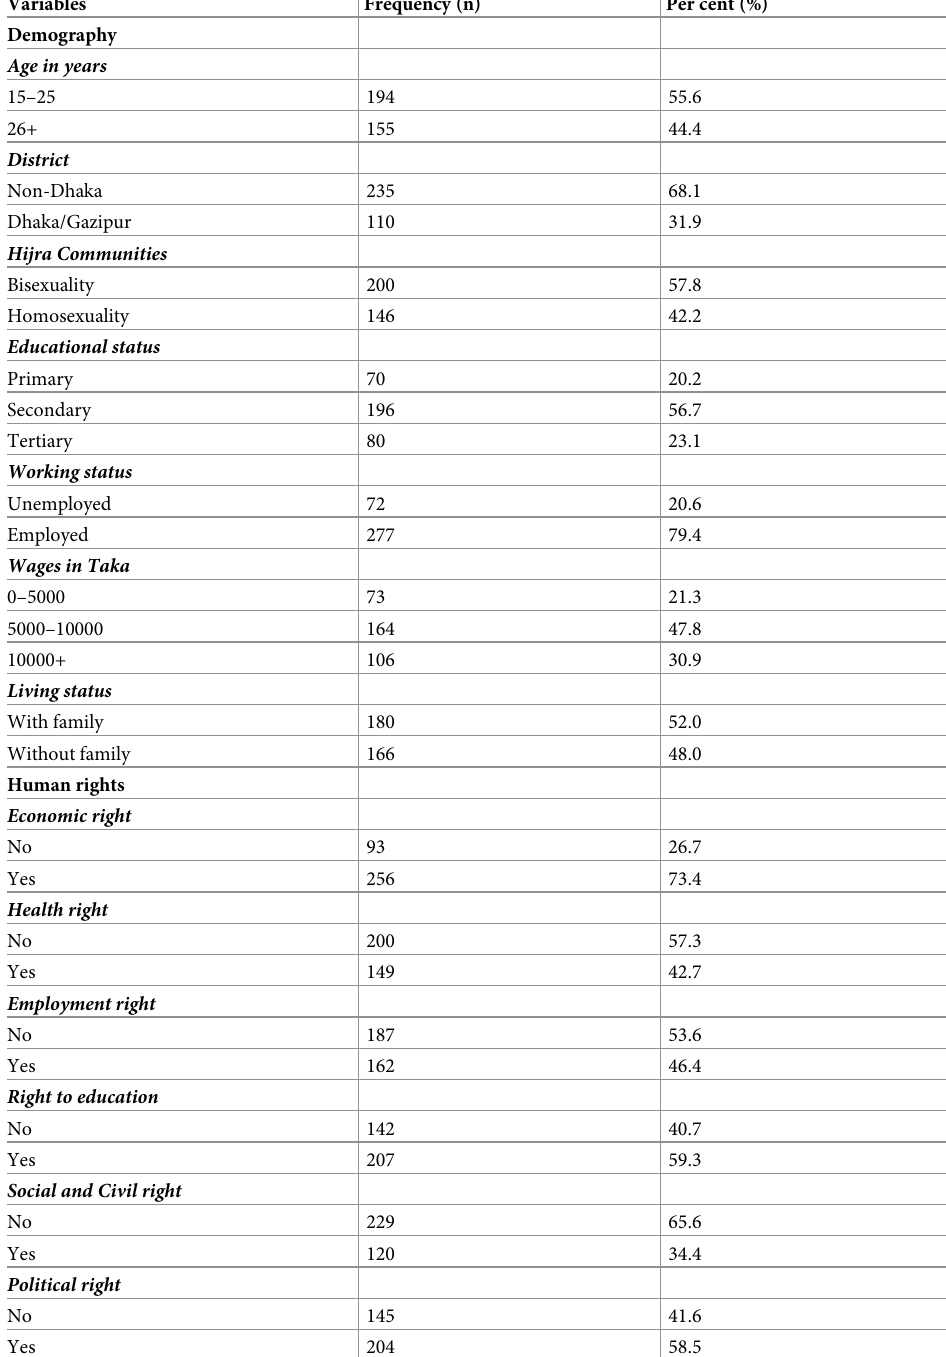
Table 2. Participant Characteristics and the categories of human right violations (n = 346). The non-Dhaka dis- trict includes: Chattogram, Mymensingh, Narayanganj and Rajshahi